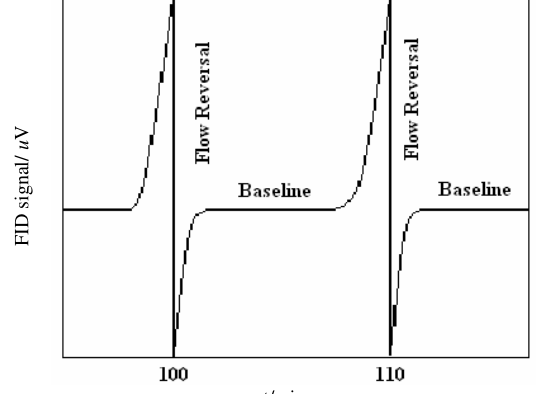
Figure 3 . Reversed-flow gas chromatogram showing two sample peaks for the adsorption of liquid pollutant at 312.15 K and 1atm ( v =1.0 cm 3 s -1 )